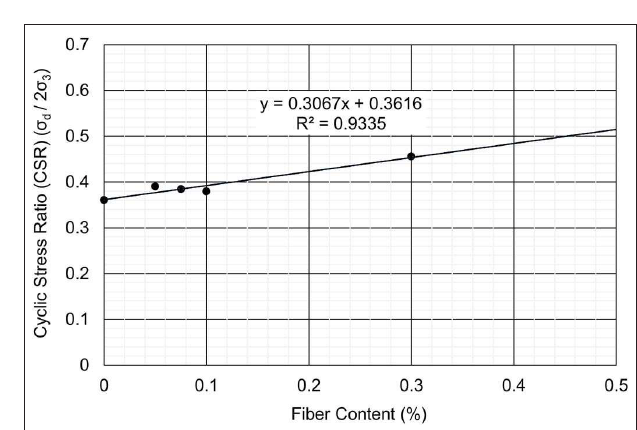
FIGURE 4 | Variation of liquefaction resistance (initial liquefaction at N = 10) of sand with fiber contents at effective confining pressures of 34.48 kPa.